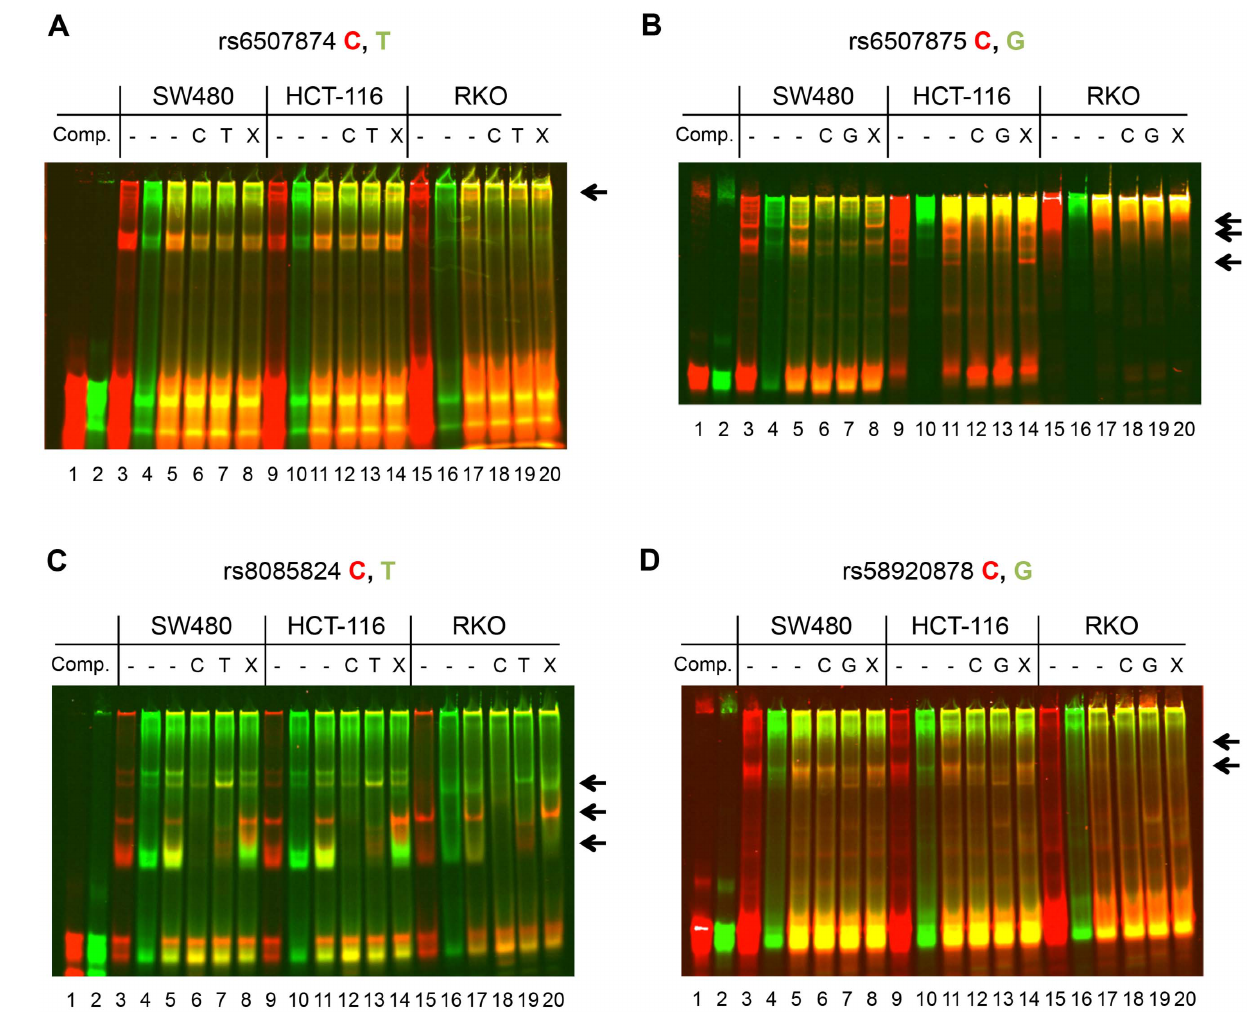
Figure 4. Differential protein binding by SNP alleles using EMSA. ( A ) Nuclear extracts from SW480, HCT-116, and RKO cell lines were incubated with IR-dye labeled 33mers centered on rs6507874 C (red label) and T (green labels) prior to native EMSA. Lanes 1 and 2 show probe without nuclear extract. Lanes 3, 4, 9, 10, 15, and 16 show each labeled probe binding to nuclear proteins individually with cell line as noted above. Lanes 5–8, 11–14, and 17–20 are a 1:1 competition with labeled C and T allele probes. Lanes 6, 12 and 18 contain 200-fold excess unlabeled C allele competitor. Lanes 7, 13, and 19 contain 200-fold excess unlabeled T allele competitor. Lanes 8, 14, and 20 contain 200-fold excess competitor of an unmatching sequence with similar nucleotide content. Bands specific for one allele and lost upon competition are marked with arrows. See Figure S2 for red (700) channel image of the C probe and the green (800) channel of the T probe in black and white. ( B ) As in panel A, with rs6507875 C allele (red probe) and G allele (green). See Figure S3 for red (700) channel image of the C probe and the green (800) channel of the G probe in black and white. ( C ) As in panel A, with rs8085824 C allele (red) and T allele (green). See Figure S4 for red (700) channel image of the C probe and the green (800) channel of the T probe in black and white. ( D ) As in panel A, with rs58920878 C allele (red) and G allele (green). See Figure S5 for red (700) channel image of the C probe and the green (800) channel of the G probe in black and white.